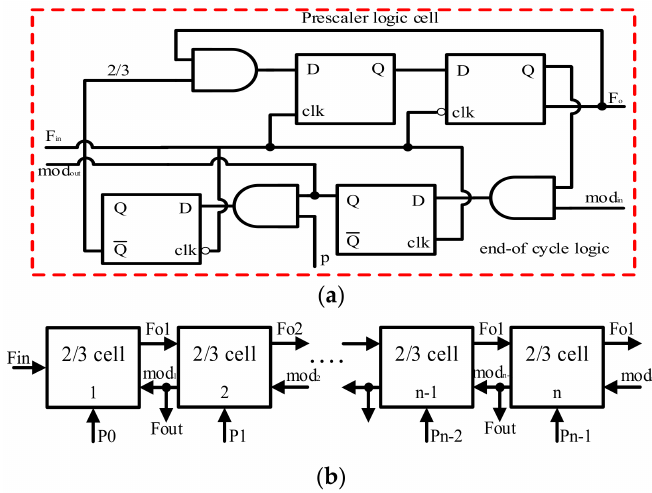
Figure 11. ( a ) Prescaler logic cell; ( b ) multi-modulus divider architecture.